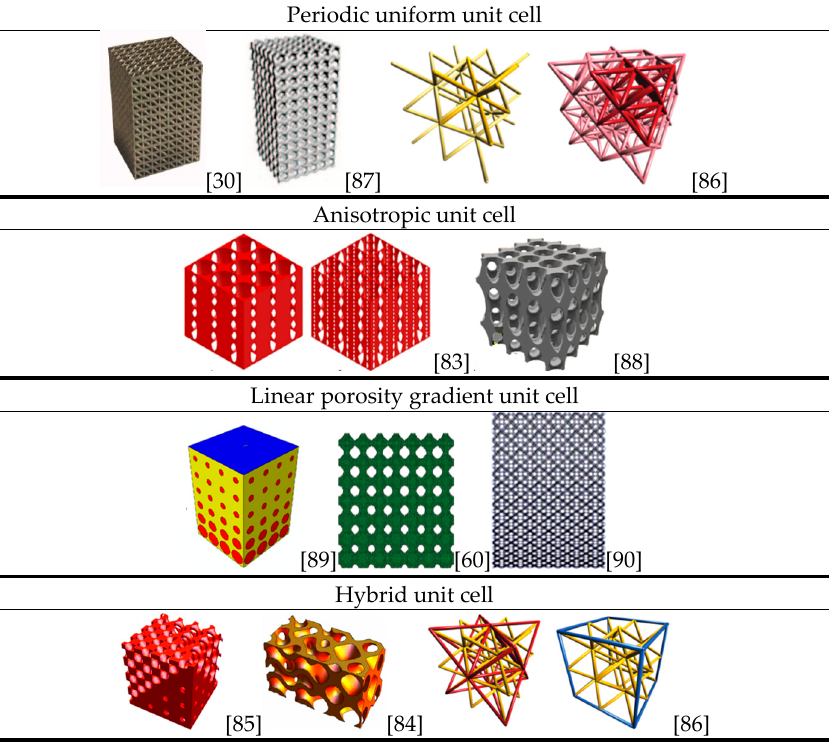
Figure 2. Scaffold designs based on different types of unit cells.